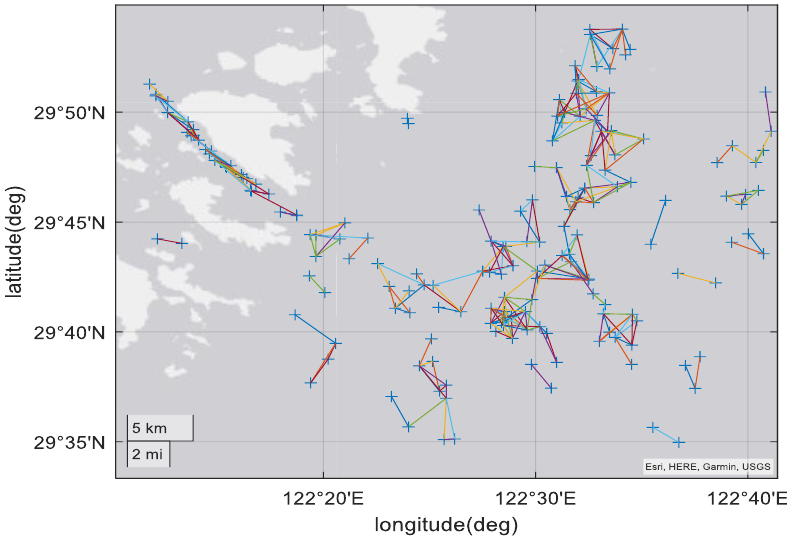
Figure 10. Ships encounter relationships based on the coordinates of vessels.